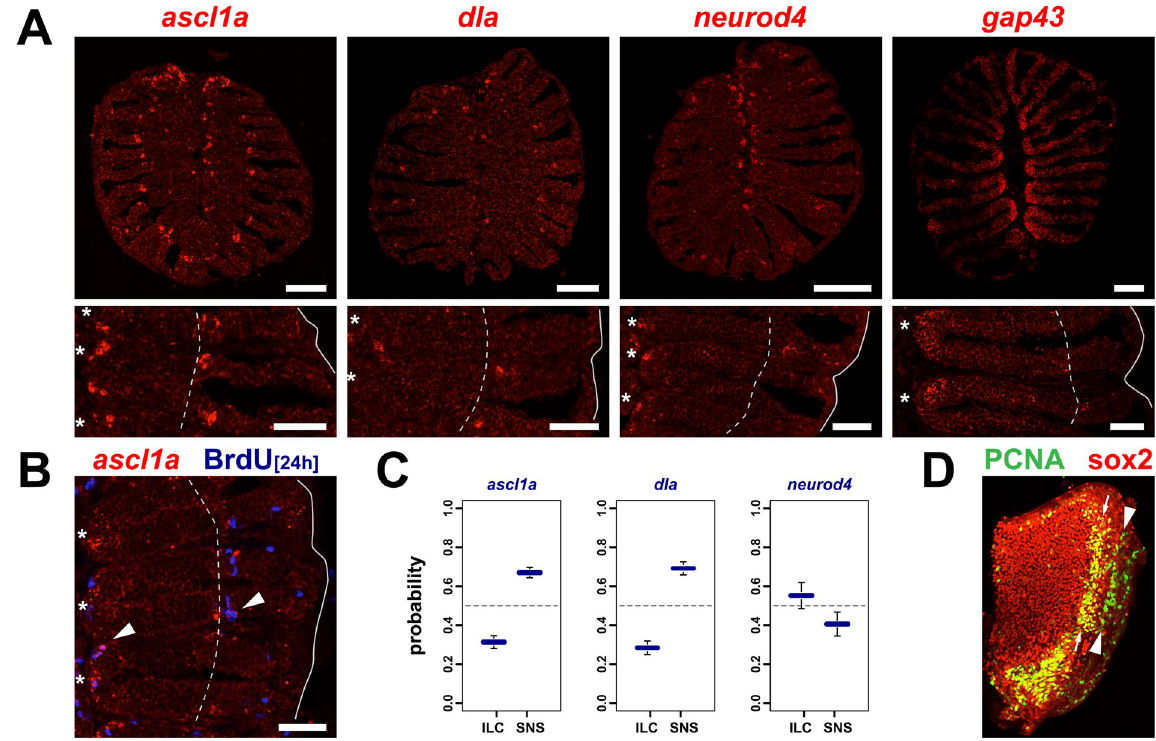
Figure 4. Neurogenesis is restricted to the central and peripheral edge of the sensory neuroepithelium. ( A ) In situ -hybridization for the early neurogenesis markers achaete scute - like 1a ( ascl1a ) and delta - like a ( dla ), and the late differentiation markers neuronal differentiation 4 ( neurod4 ) and growth associated protein 43 ( gap43 ) on full cross sections through the adult OE (top) and higher power views of one side of the OE (bottom). Expression of the neurogenic markers is restricted to the interlamellar curves (asterisks) and sensory/nonsensory border (dotted line). The solid line indicates the outline of the section. Scale bars: 100 µ m (top panel), 50 µ m (bottom panel). ( B ) Ascl1a -expressing cells are actively dividing. In situ hybridization for ascl1a (red) and immunohistochemistry against BrdU following 24 h incubation with the marker to highlight dividing cells. Double positive cells (arrowheads) can be identified at the interlamellar curves (asterisks) and the sensory/ nonsensory border (dotted line). Scale bar: 50 µ m. ( C ) Quantification of the distribution of cells expressing the neurogenic markers ascl1a , dla , and neurod4 at the interlamellar curves (ILC) and sensory nonsensory border (SNS; means ± SEM for ascl1: 8 sections from 2 fish, dla: 9 sections from 3 fish, neurod4: 8 sections from 2 fish). Cells expressing the markers are unevenly distributed between the two proliferation zones; more ascl1a - and dla -expressing cells can be found at the SNS, whereas more neurod4 -positive cells locate to the ILC. ( D ) Immunohistochemistry against the mitotic marker proliferating cell nuclear antigen (PCNA, green) and the neuronal stem cell marker sox2 (red) on a single whole mount olfactory lamella. Two rows of dividing cells can be identified in the peripheral nonsensory OE, cells at the inner band (arrows) are double positive for sox2 and appear yellow, while dividing cells in the peripheral OE (arrowheads) are devoid of sox2 expression. Note that most of the double-positive dividing cells at the interlamellar curve (left end of the lamella) are not included due to the dissection of the